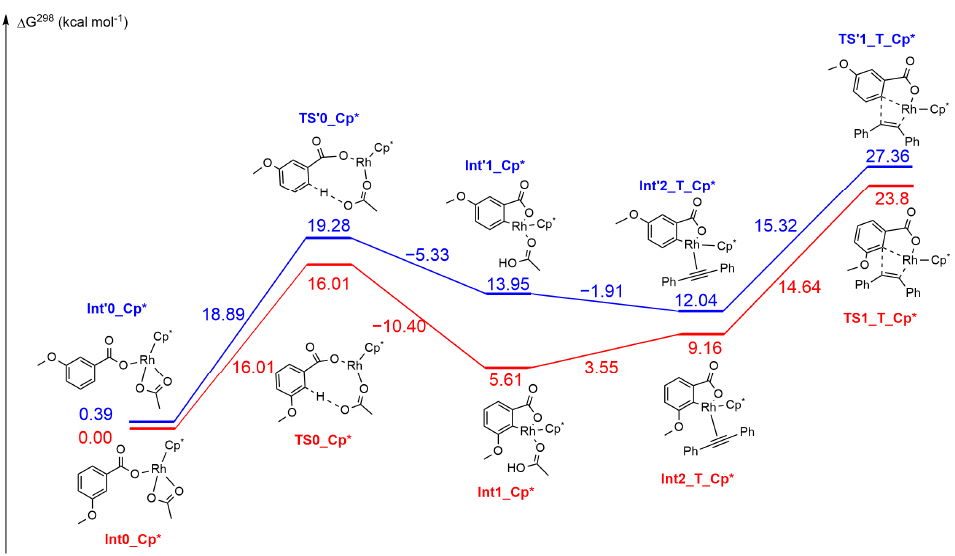
Figure 5. Energy profiles of C-H activation and alkyne insertion steps for the annulation of 1a with diphenylacetylene catalyzed by [Cp*RhCl 2 ] 2 . The calculated Gibbs free energies are given relative to the Int0_Cp* intermediate at the M06L(D3)/LANL2DZ level with CPCM correction for methanol solvation (in kcal ⋅ mol − 1 , at 298 K).